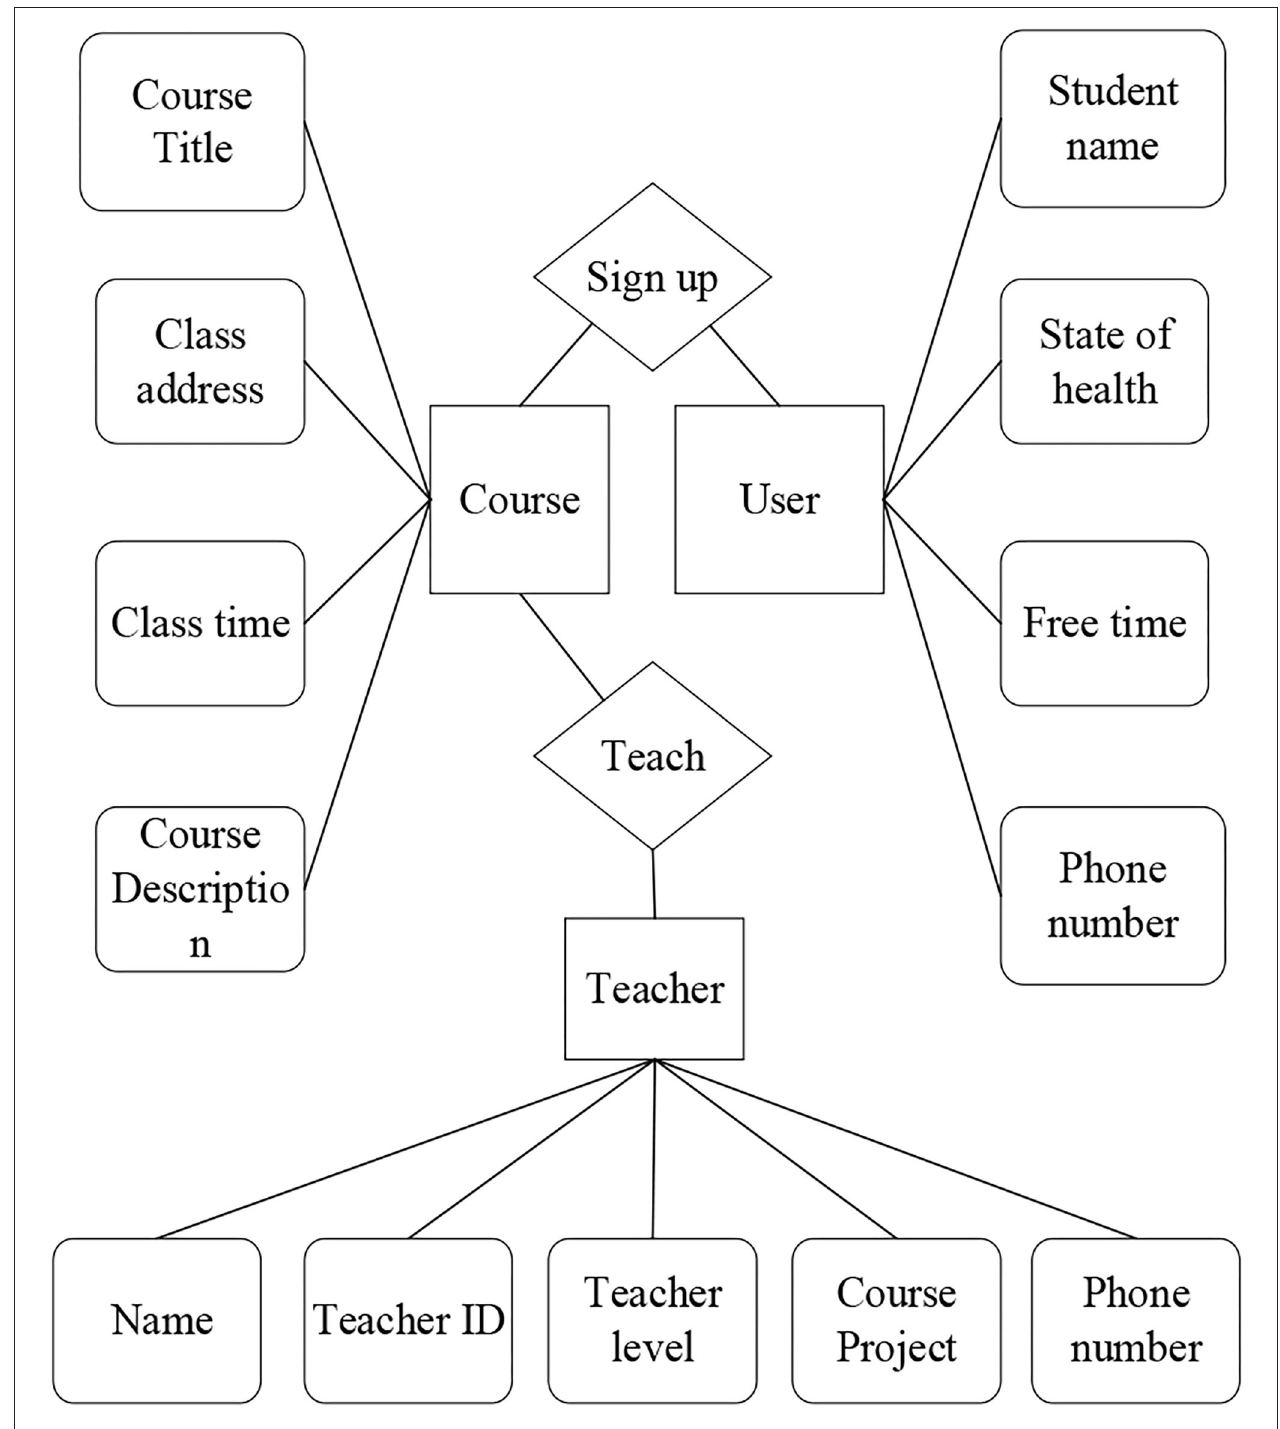
FIGURE 5 | E-R diagram of course